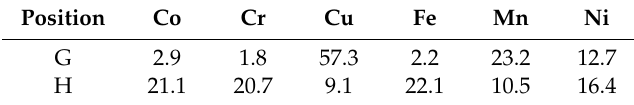
Figure 7. SEM-BSE images of the arc-melted ingots of the non-B CoCrCu x FeMnNi (x = 1, 2, 3) (Cu1, Cu2 Cu3) HEAs. (a) Cu1, (b) Cu2, (c) Cu3. Table 2. Chemical composition analysis results of the ratio of metallic element without considering B (atomic percent ratio) in the arc-melted ingots of the CoCrCuFeMnNiB 0.2 (Cu1B02) HEA evaluated using